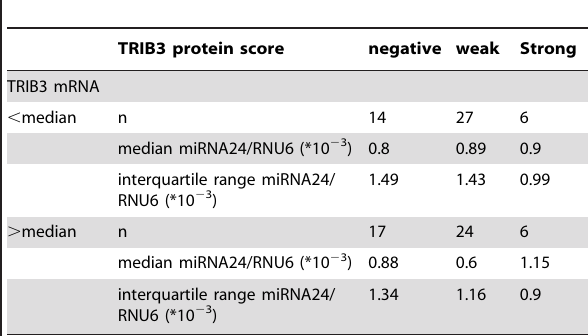
Table 2. miRNA 24 expression levels in groups with accordance and discordance between TRIB3 mRNA and